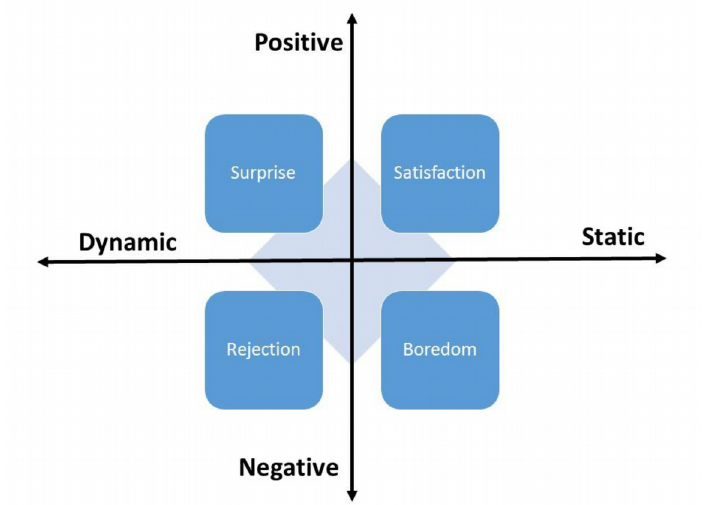
Figure 1. The taxonomy of emotions that was used in this